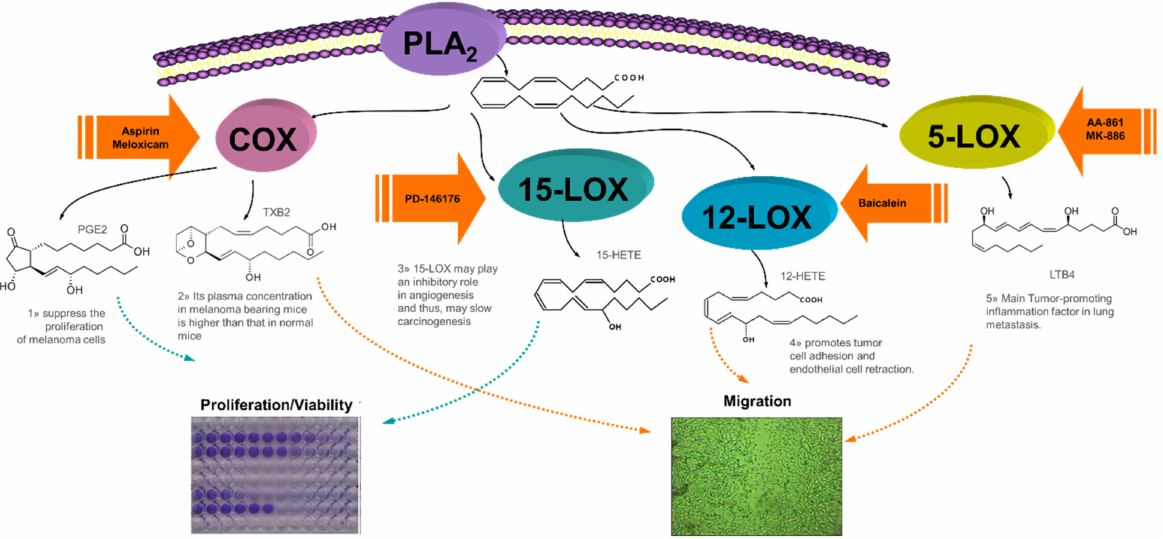
Figure 2. Interplay of COX/LOX metabolites in the proliferation, migration and invasion of melanoma B16F10 cells (authors’ own